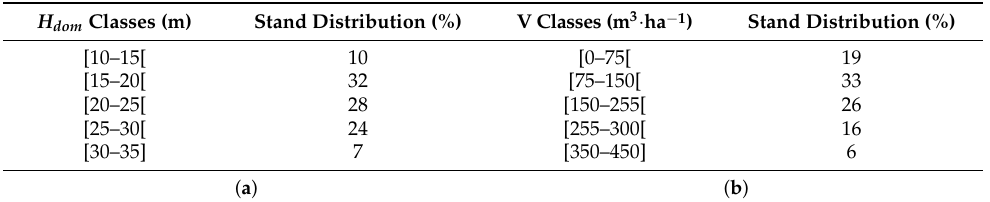
Table 1. Distribution of dominant canopy height ( a ) and wood volume densities ( b ) from field inventories over the 168 Eucalyptus stands.